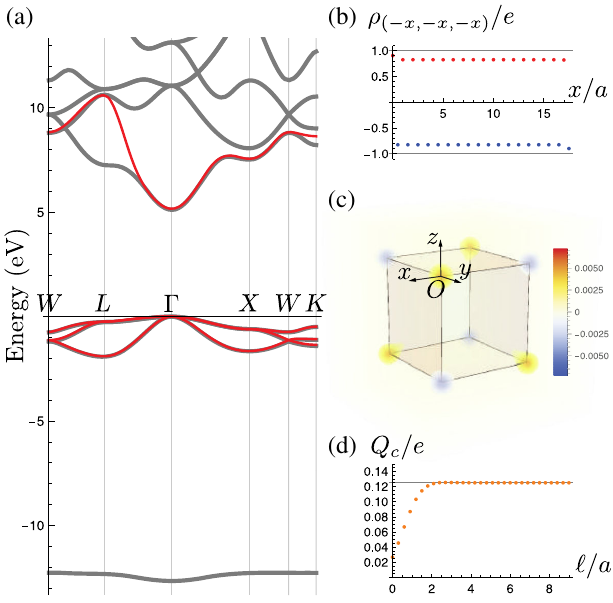
FIG. 3. (a) The band structure of our tight-binding model (red lines) and the first-principles calculation (gray lines). (b) The charge distribution ρ r in the diagonal direction. (c) The coarse- ð r Þ . (d) The corner charge Q grained charge density ˜ ρ c in Eq. (9) tot as a function of l